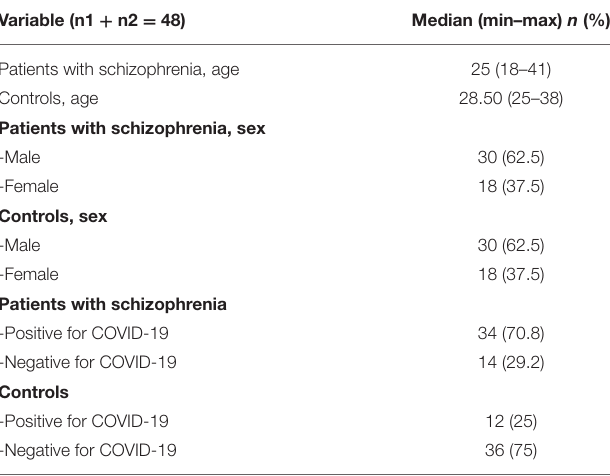
TABLE 3 | Correlation of the sex of the patients with schizophrenia and the controls with COVID-19.